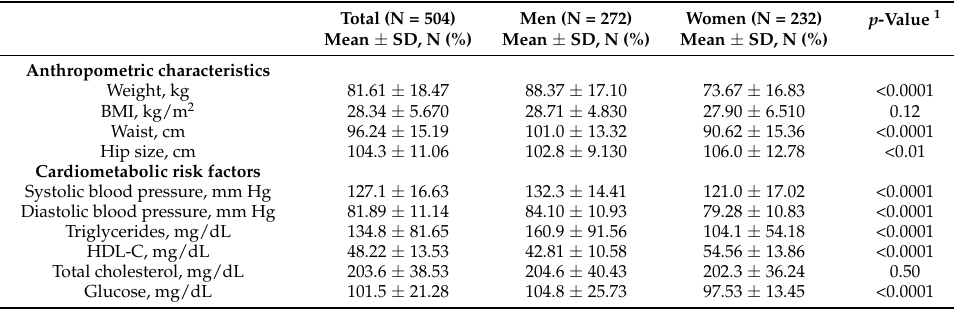
Table 1. Cardiometabolic characteristics of the sample stratified by sex (N =